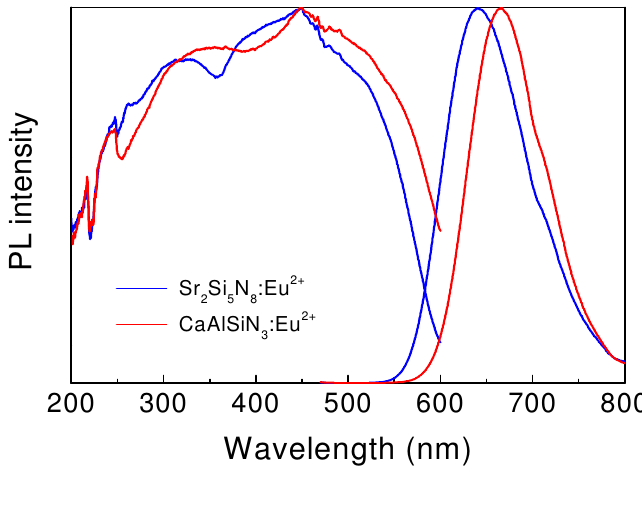
Si N :Eu 2+ and CaAlSiN 2 5 8